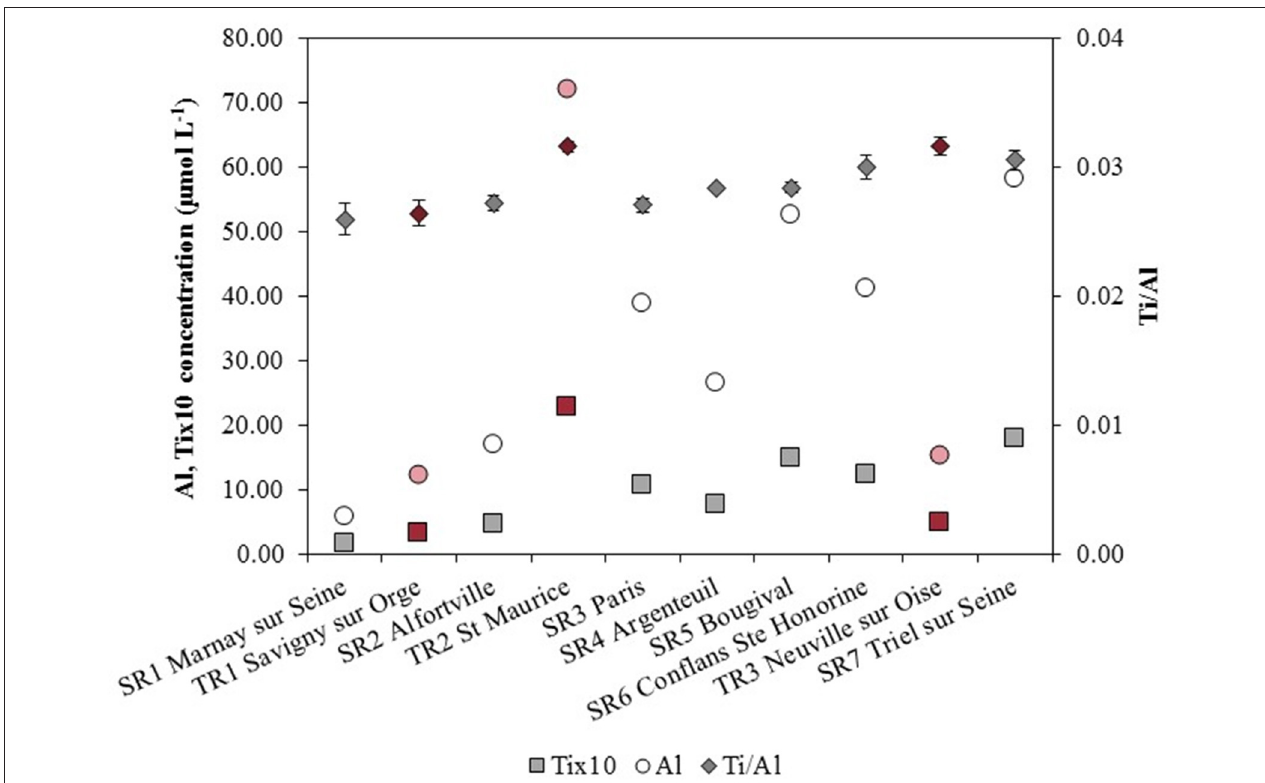
FIGURE 4 | Ti and Al total concentrations (left-hand side axis) and Ti/Al elemental ratios (right-hand side axis) for the different sampling sites from SR1 to SR7 (in gray), with the three different tributaries (in red).